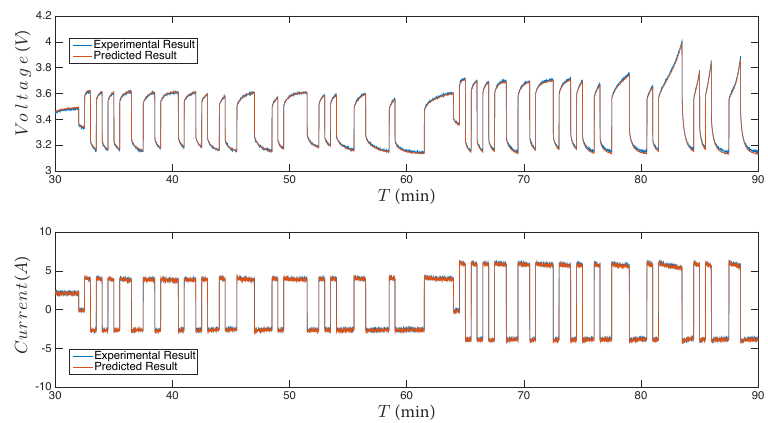
Figure 11. Validation results of dynamic voltage and current models with one-step-ahead voltage and current predictors ˆ v ( t | t − 1 ) and ˆ i ( t | t − 1 ) in the last 60 min.